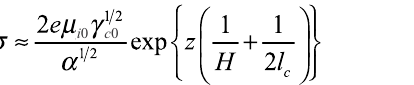
Figure 1. Model distribution of the air conductivity with altitude. The air conductivity for the aerosol number densities n cm -3 is shown with lines 1 and 2 while the same value for n cm -3 is shown with lines 3 and 4. The sea level rate c duction for the lines 2 and 4 is twice as great as that for the lines 1 and 3. Calculation from the empirical equation v = v shown with line